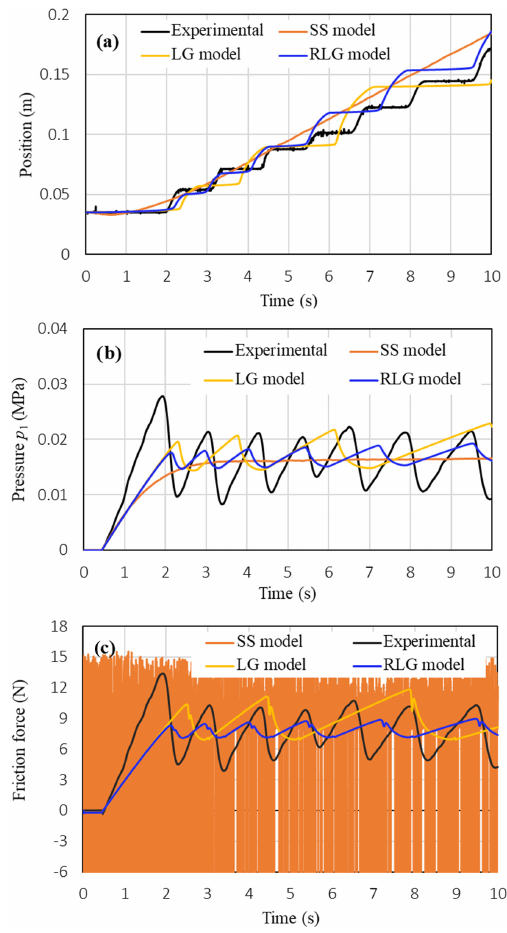
Figure 10. Comparison between measured characteristics of the piston position, pressures and friction force and those simulated us- ing the three friction models: (a) position, (b) pressure p 1 , (c) fric- tion force ( M = 0 . 5kg, u 1 = 2 . 875V, u 2 = 2 .